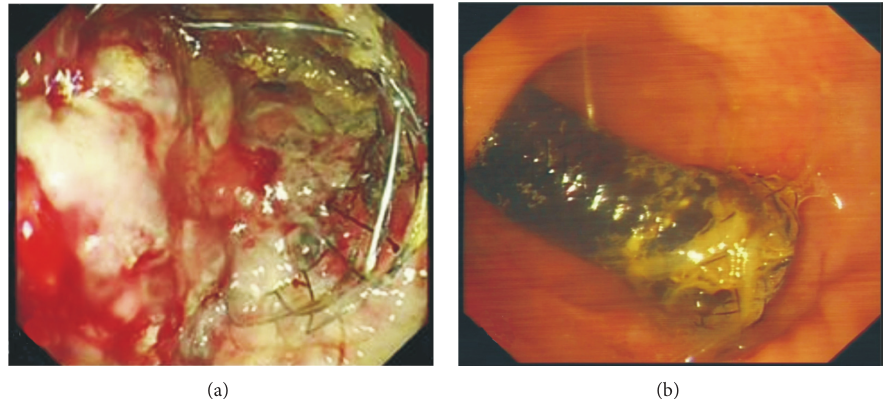
Figure 3: Images of stents taken by endoscopy. (a) An example of standard uncovered stent obstruction caused by tumor ingrowth and overgrowth. (b) An example of a funnel-shaped GOO tailored stent that had partly migrated into the